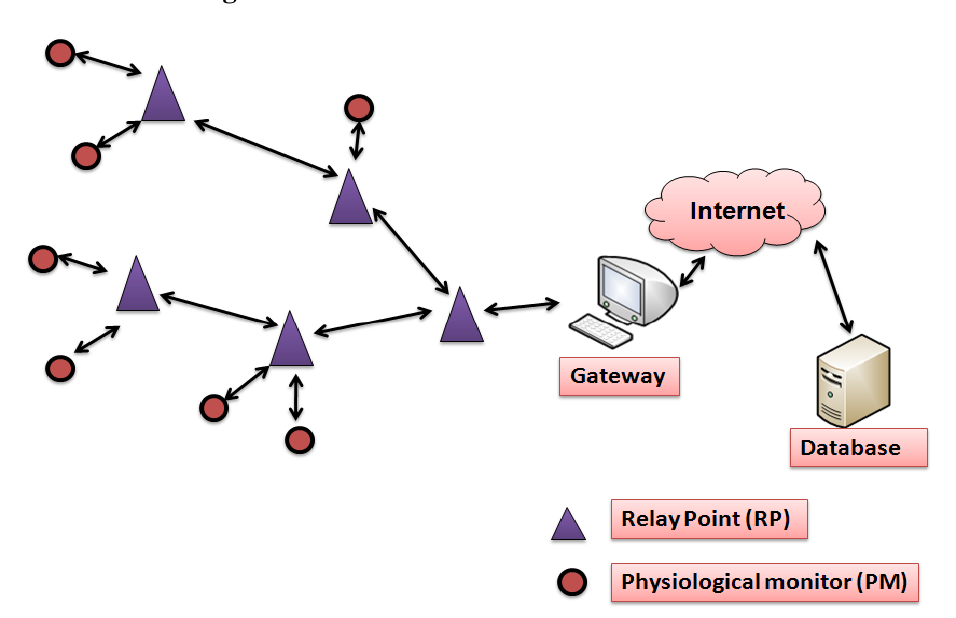
Figure 7. Healthcare architecture of